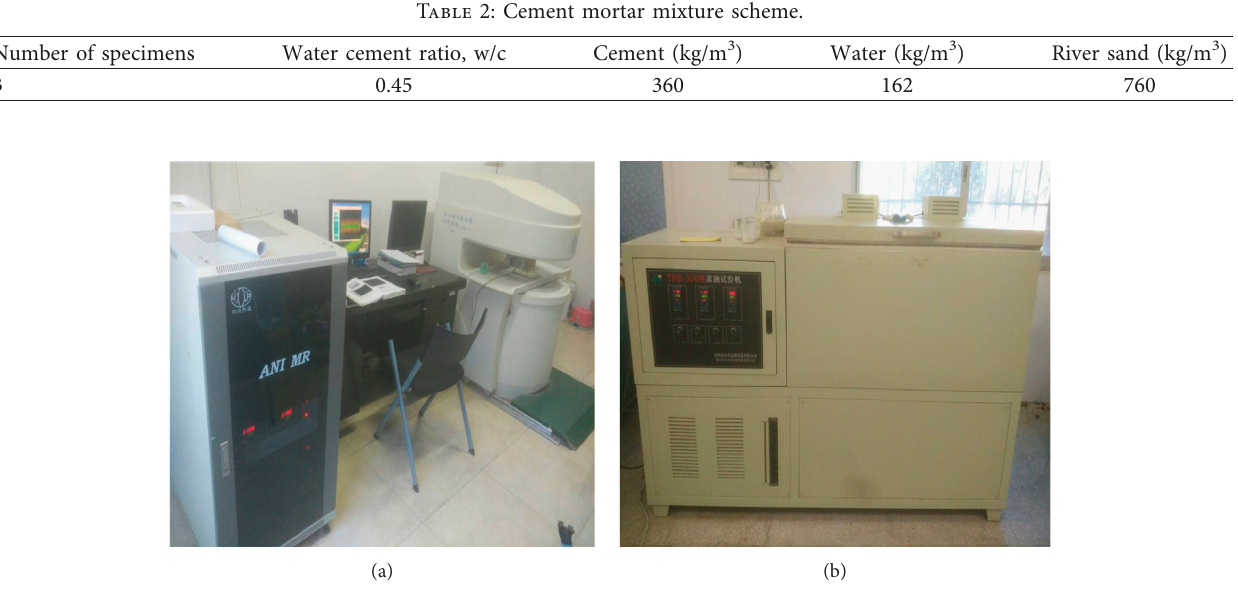
Figure 1: Main experimental equipment. (a) NMR test system. (b) Freeze-thaw cycle test machine.